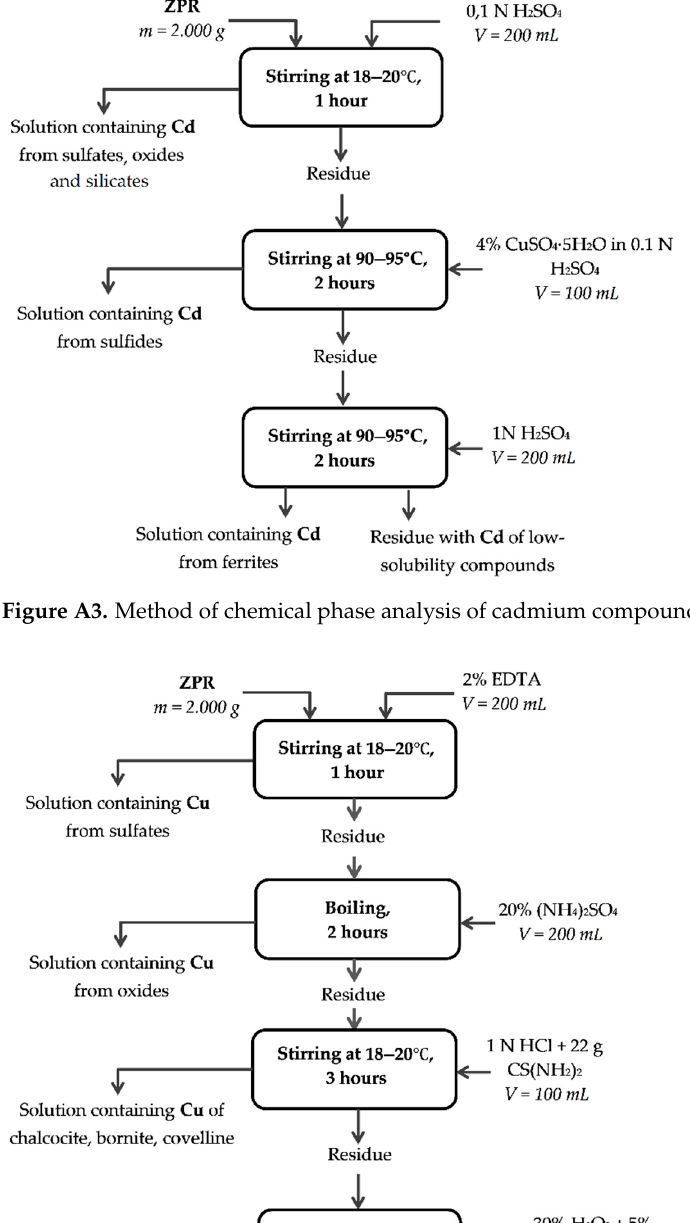
Figure A2. Method of chemical phase analysis of zinc compounds.